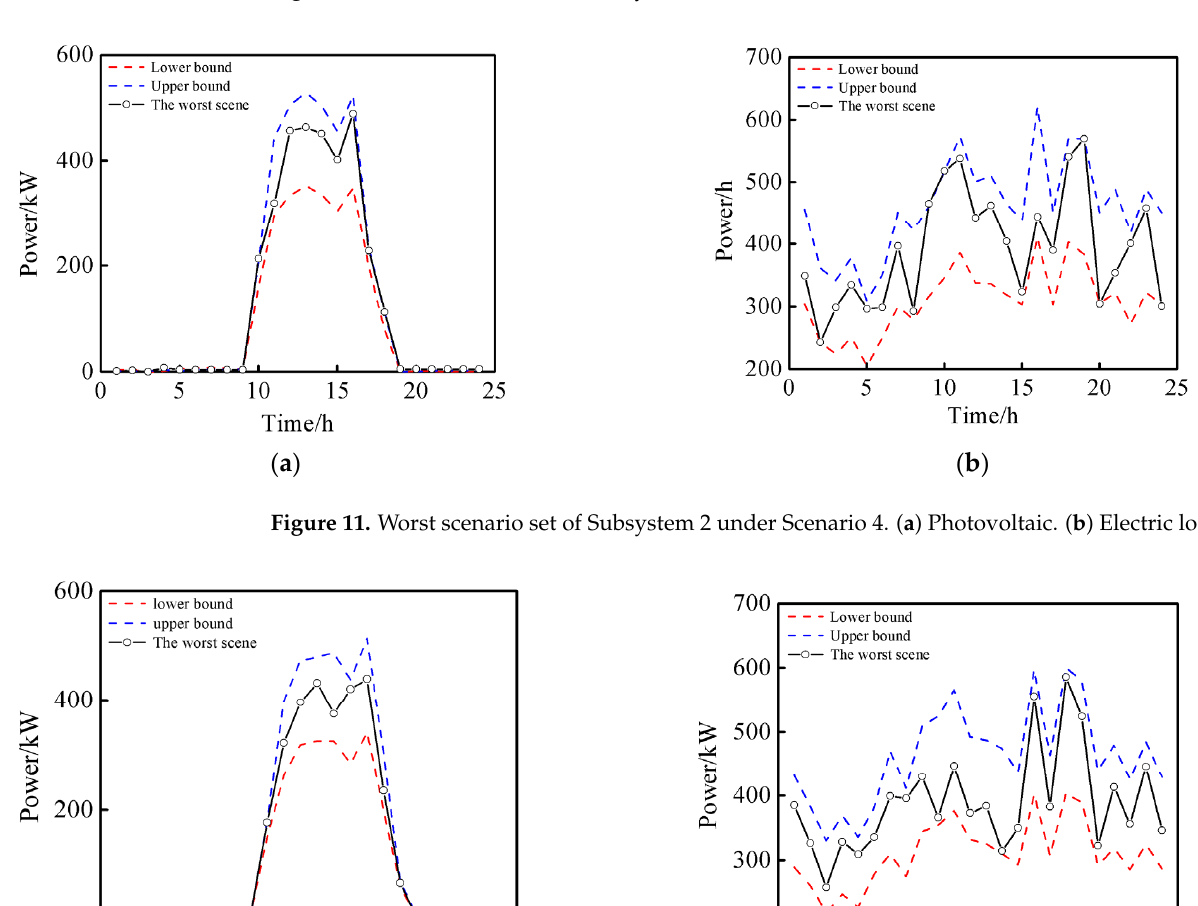
Energies 2022 , 15 , x FOR PEER REVIEW